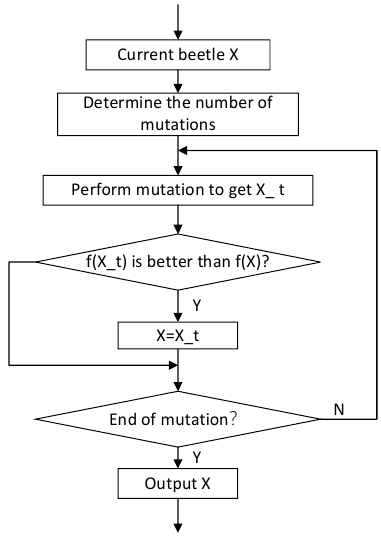
Figure 2. Flow chart of variation.